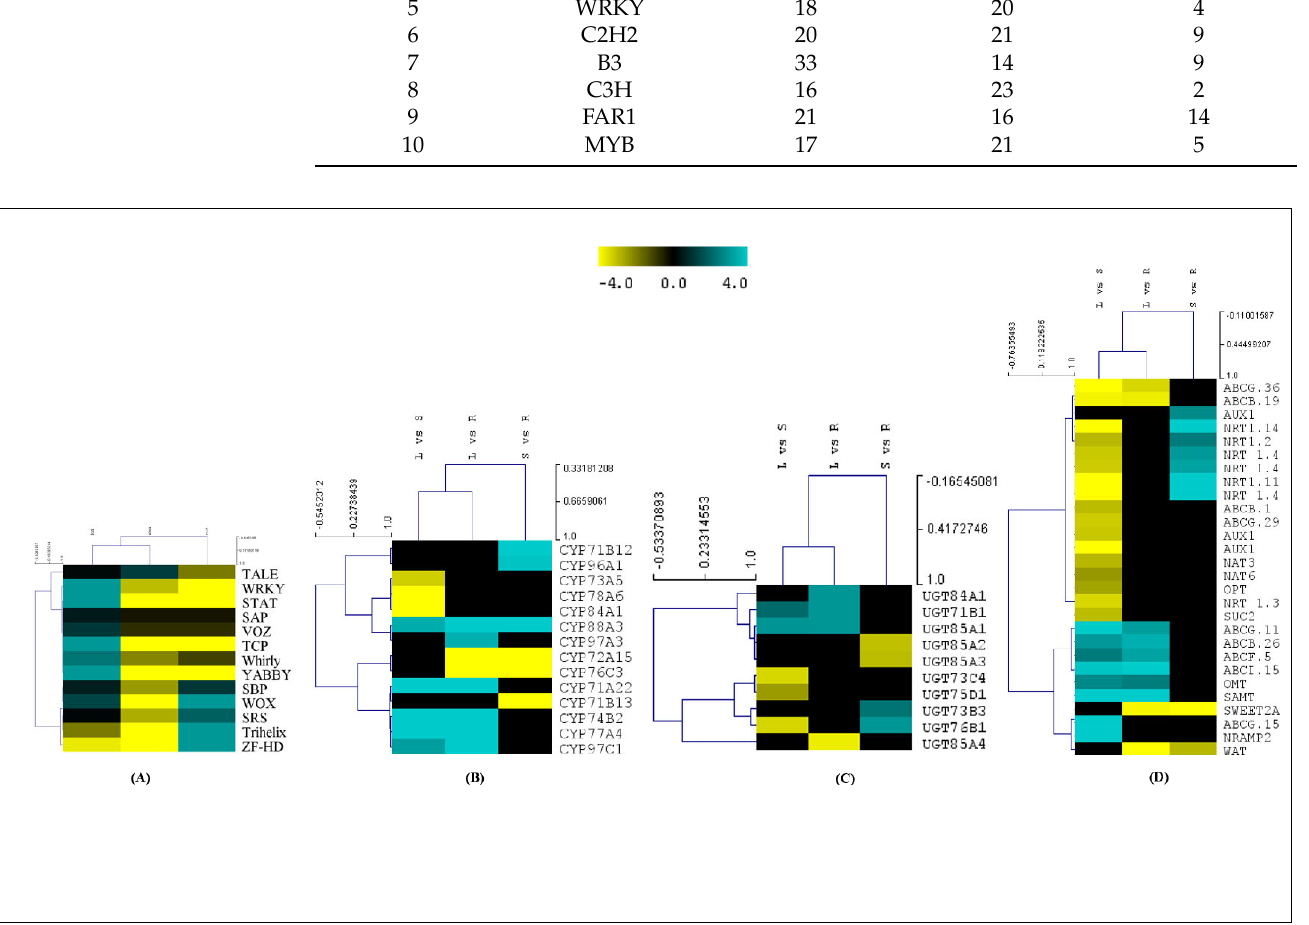
Figure 8. Heatmap visualization of differentially expressed transcripts of: ( A ) transcription factors (in leaf, stem, and root); ( B ) CYP; ( C ) UGT; ( D ) transporters in three combinations (L vs. S; L vs. R; S vs. R), of A. glauca . S vs. R), of A. glauca